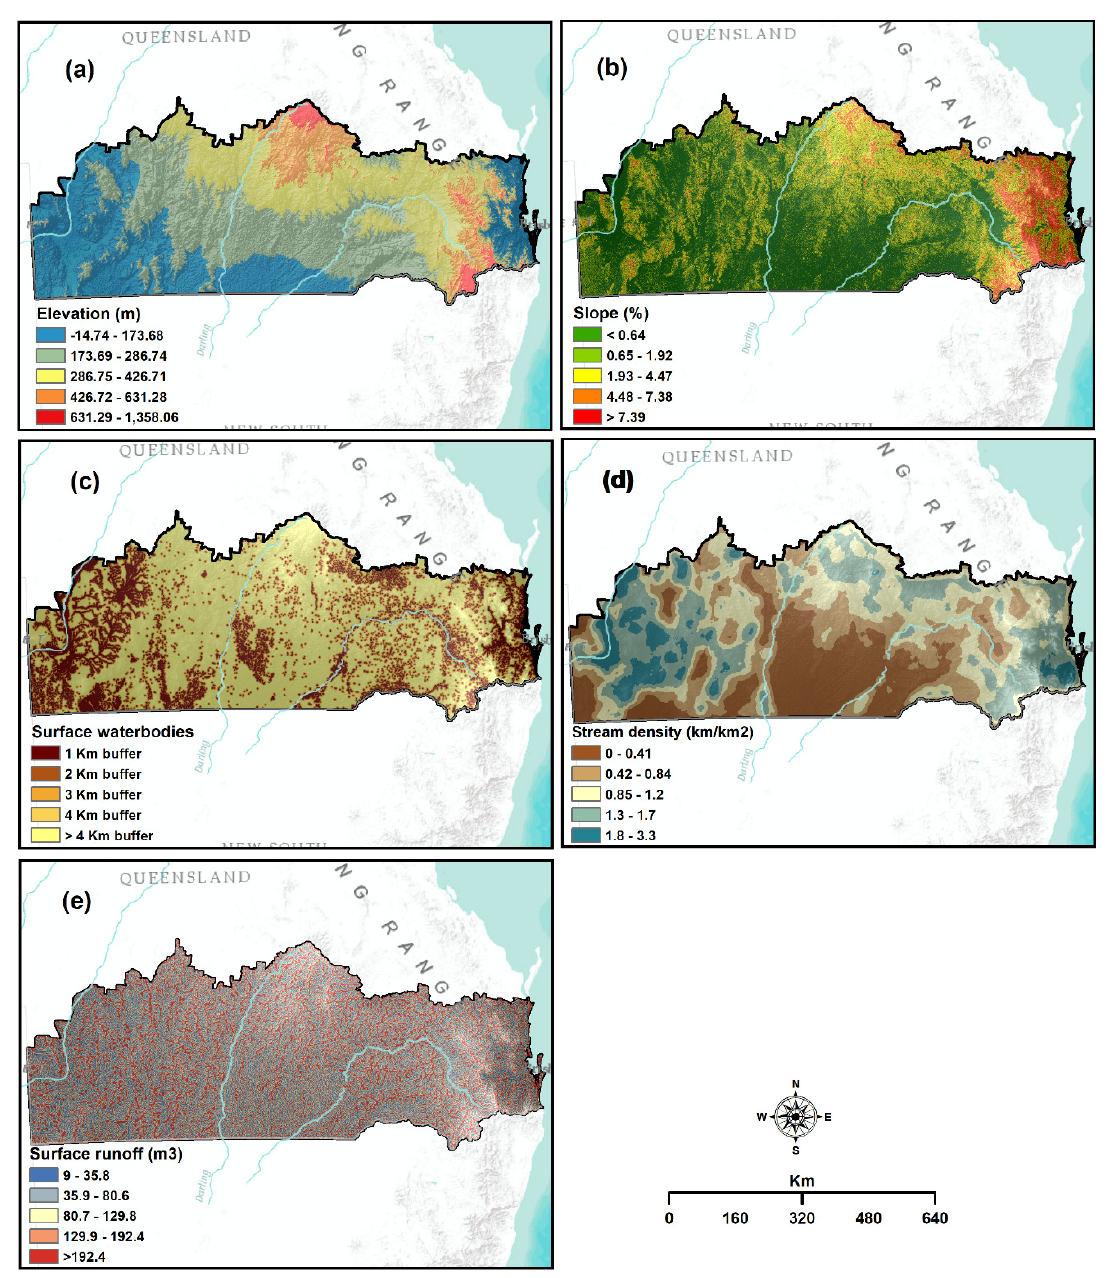
Figure 4. Thematic layers used for hydrological drought vulnerability: ( a ) elevation; ( b ) slope; ( c ) surface water bodies; ( d ) stream density; and ( e ) surface runoff.